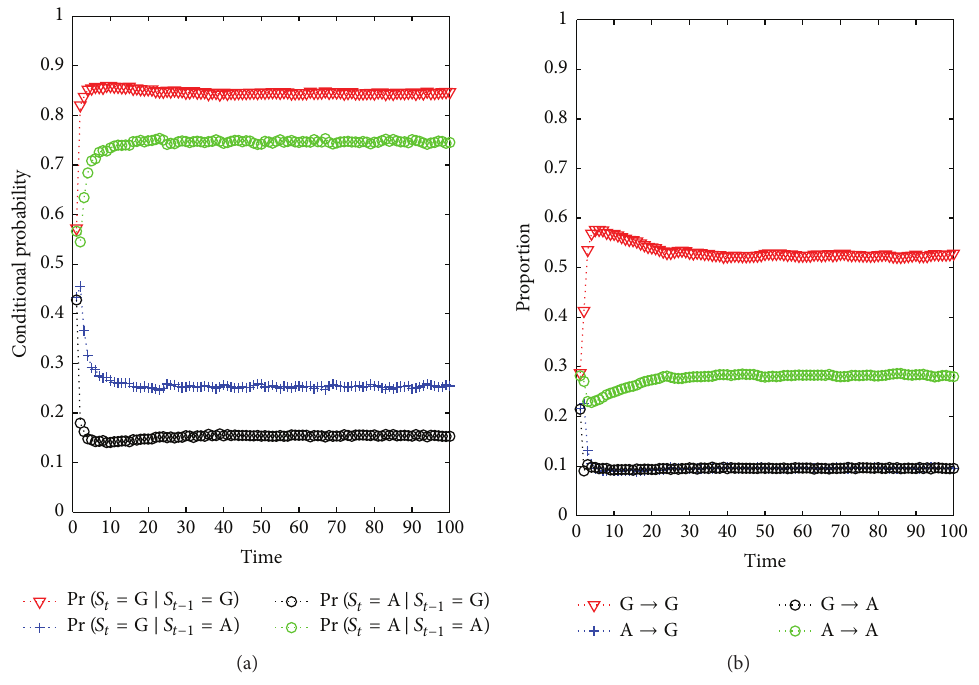
Figure 5: The (a) conditional probability and the (b) proportion of the strategy changing.